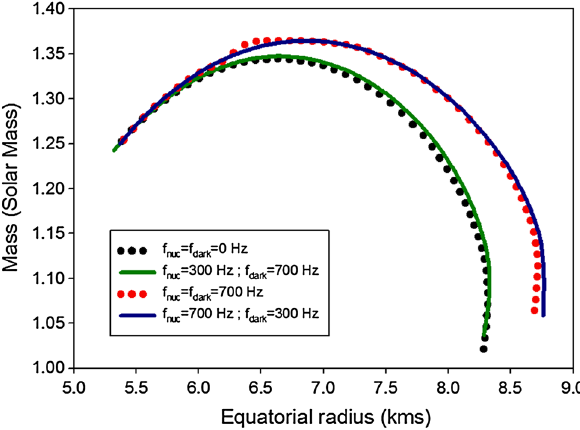
Fig. 7 Plots of total mass vs. equatorial radius of static, rigidly rotat- ing and differentially rotating neutron stars mixed with interacting